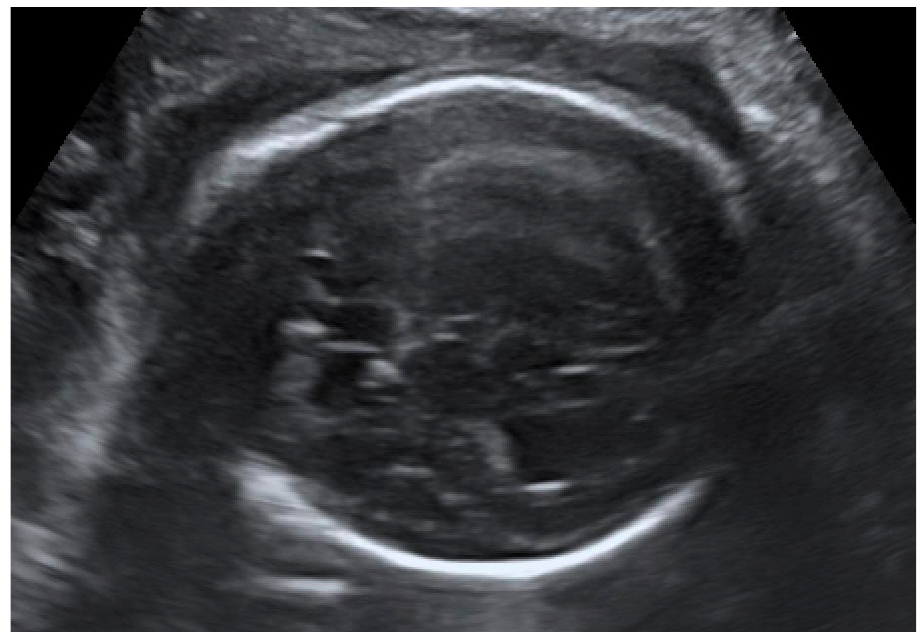
Figure 3. Dilation of the anterior and posterior horns of the lateral and third ventricles.